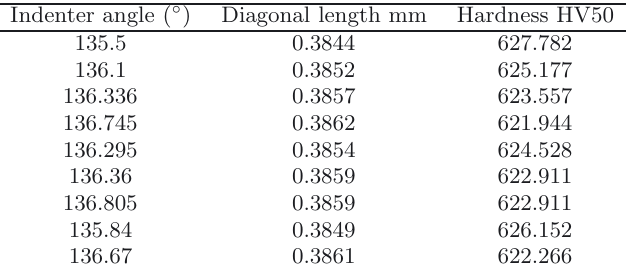
Fig. 7. (Color online) The finite element model for Vickers hardness test. Table 3. Results of finite element